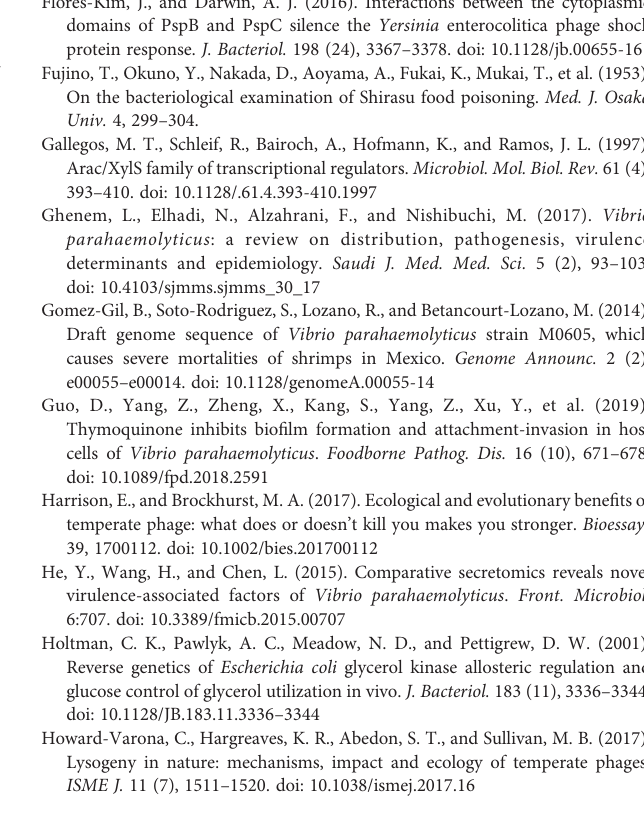
positive exconjugants; Line 6, positive control;Line 7, blank control. (F) amplicons of exconjugants with the VpaChn25_0724 -up-ex-F and VpaChn25_0724 -down-ex-R primers. Lines 1 – 22, selectedexconjugants strains; Line 23, blank control;Line 24, genomicDANcontrol. (G) Ampliconsofthe tlh genefrom D VpaChn25_0724 mutants.